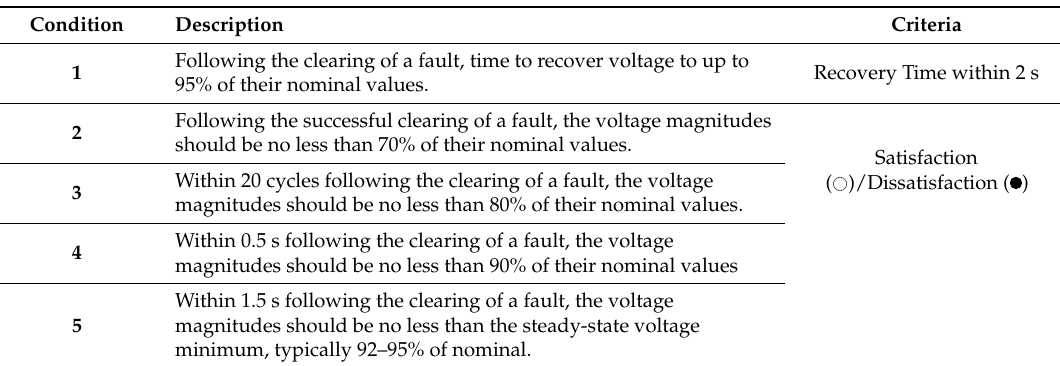
Table 3. Determination of voltage stability